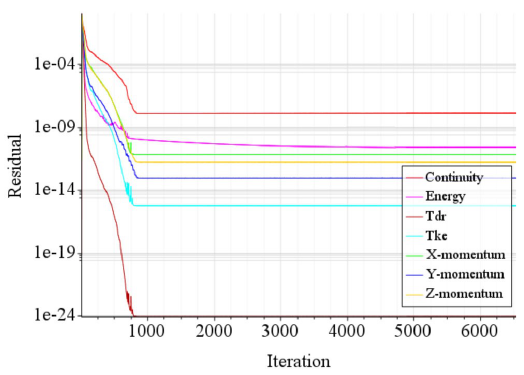
Fig. 6 . The residuals as a function of